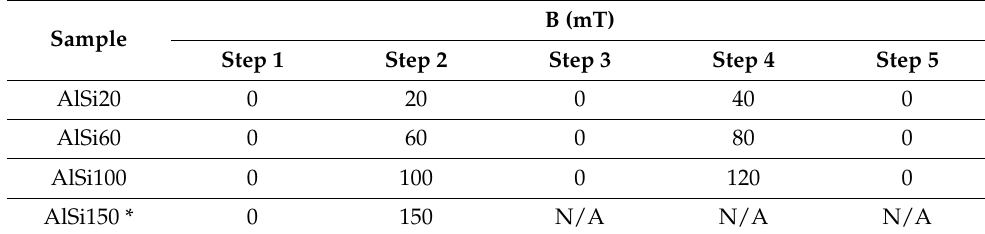
Table 1. Magnetic intensity profile during